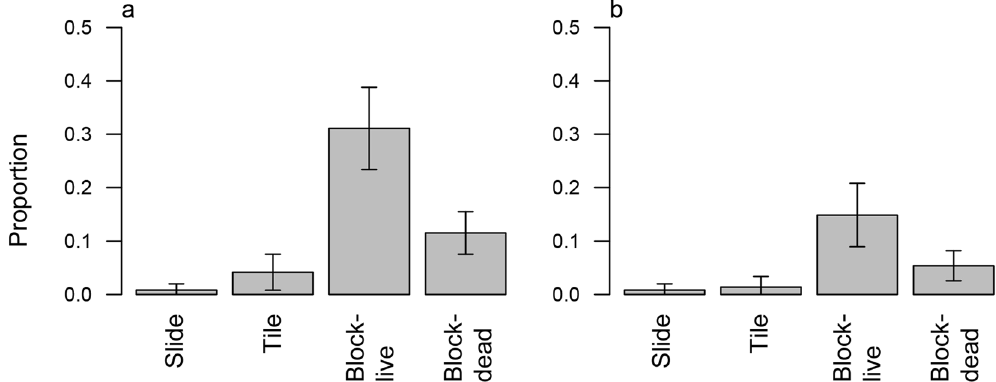
Figure 4. Settlement success of coral larvae in oscillating flume tank. Proportion of Isopora cuneata larvae making ( a ) contact with settlement substrates covered with CCA and forming ( b ) attachment for more than 5 min. Substrate treatments were: microscope slide, flat settlement tile and block. For substrates where contact was observed, flume experiments were run separately with live and dead larvae. Standard errors illustrate statistical differences; also see Table 3.